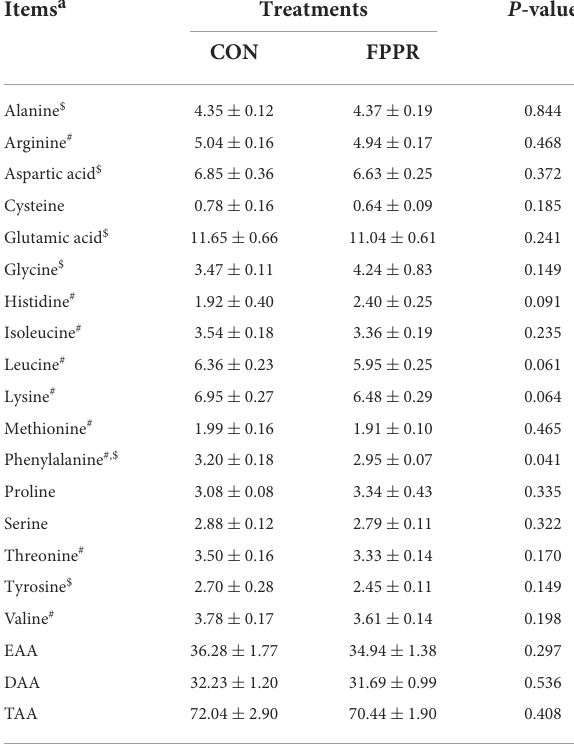
TABLE 3 Effect of the partial substitution of FPPR for WSC on the amino acid composition of longissimus dorsi in Chuangzhong black goats (g/100g